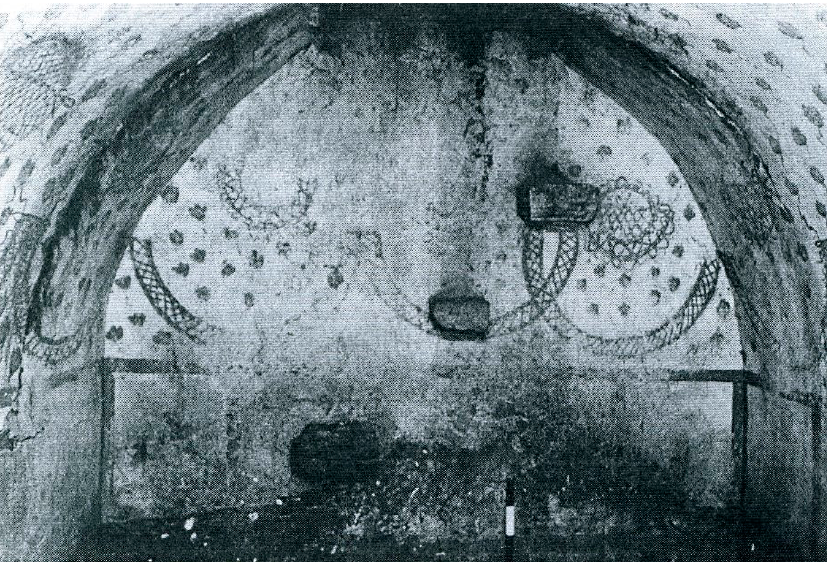
Figure 23. Sardis, Tomb 79.1 (Appendix A.8), east wall. © Archaeological Exploration of Sardis/President and fellows of Harvard College. Arts 2019 , 8 , x FOR PEER REVIEW